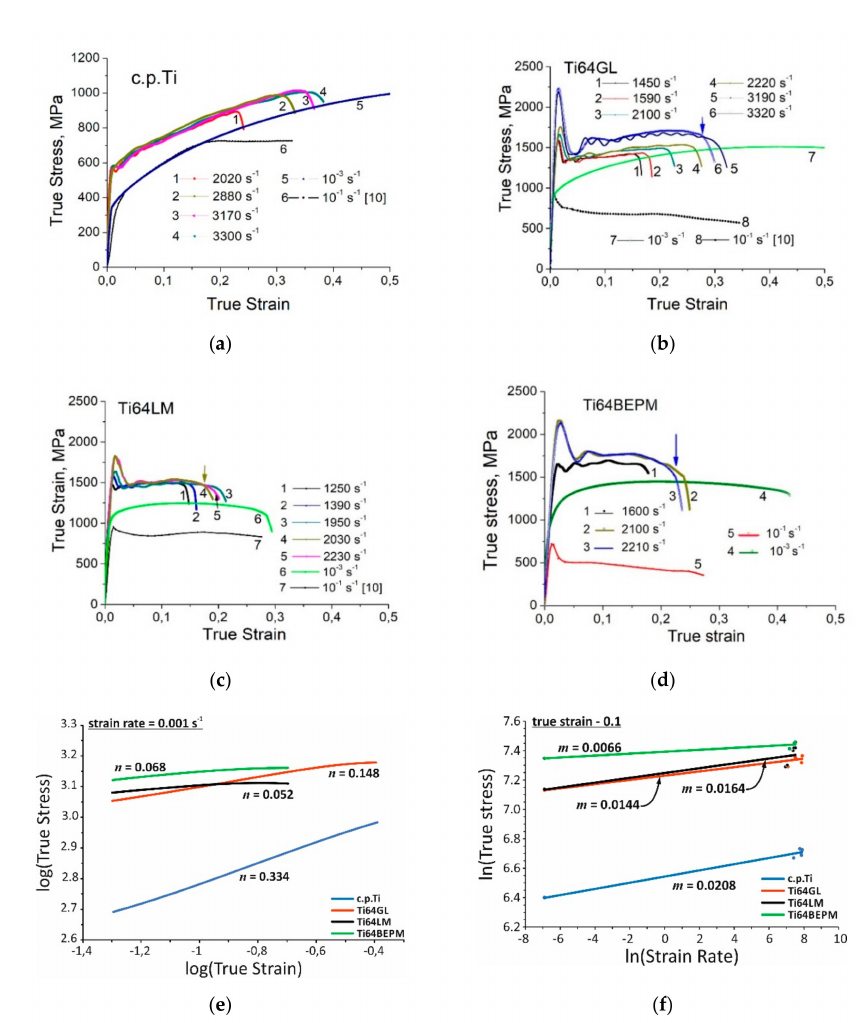
Figure 5. Quasi-static and dynamic stress–strain curves and the calculated mechanical data for: ( a ) c.p.Ti; ( b ) Ti64Gl; ( c ) Ti64LM; ( d ) Ti64BEPM (arrows in ( b , d ) indicate possible moment of fracture for relevant curves); ( e ) strain hardening coe ffi cient— n ; ( f ) strain rate sensitivity exponent— m